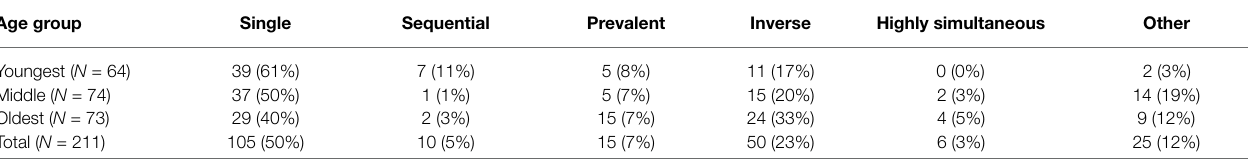
TABLE 1 | The number and percentage of the coded AES patterns when the emotions are averaged into positive and negative emotions. Age group Single Sequential Prevalent Inverse Highly simultaneous